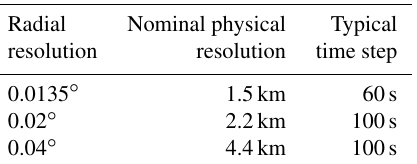
Table 1. Typical time step for a range of horizontal resolutions.